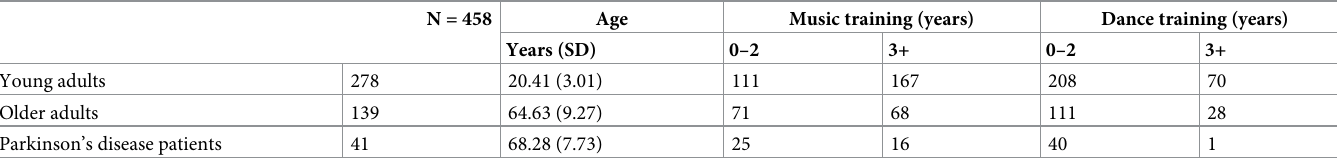
Table 1. Participant